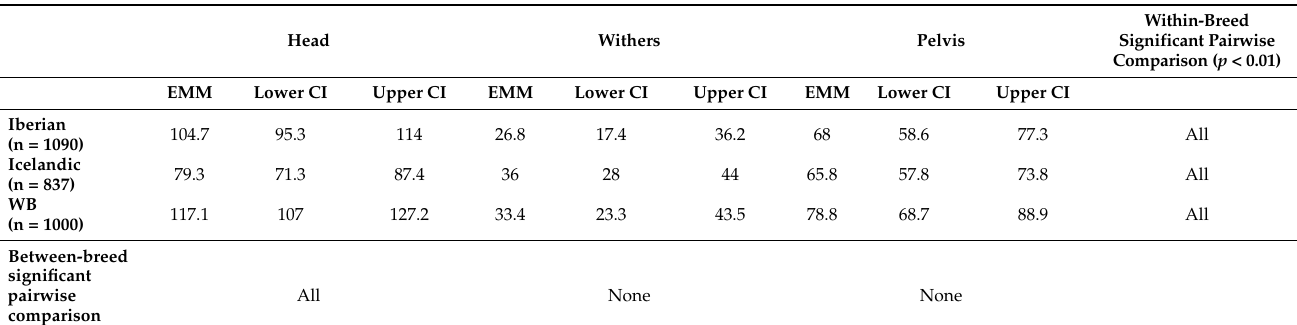
Table 2. Vertical range of motion (mm) at walk in hand for head, withers and pelvis. Results presented are estimated marginal means (EMM) with confidence intervals (CI) from the linear mixed model with pairwise comparisons. n = number of strides.